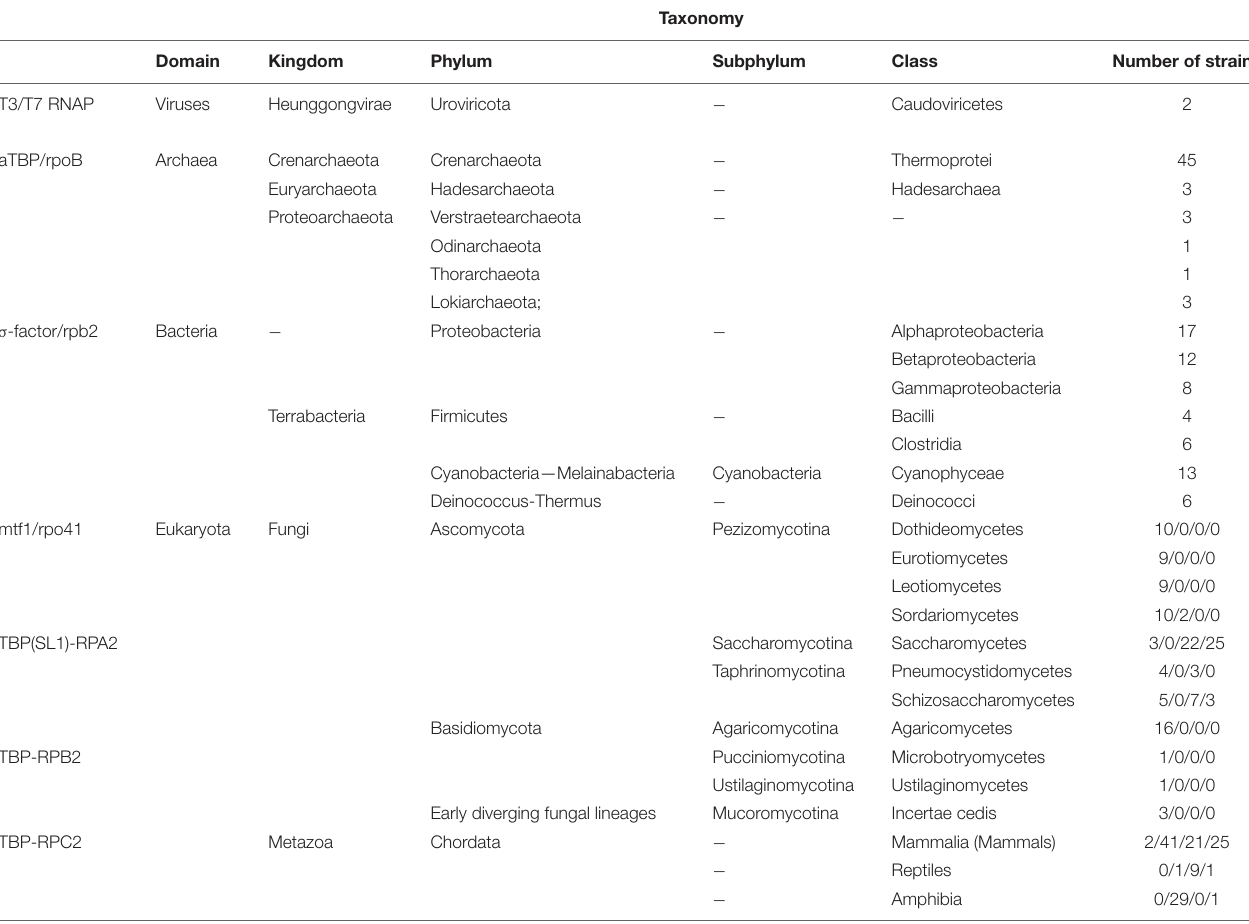
TABLE 3 | Distribution of transcription factors and RNA polymerase subunits used in the phylogenetic analyses from species belonging to all domains of life and their taxonomic classification.